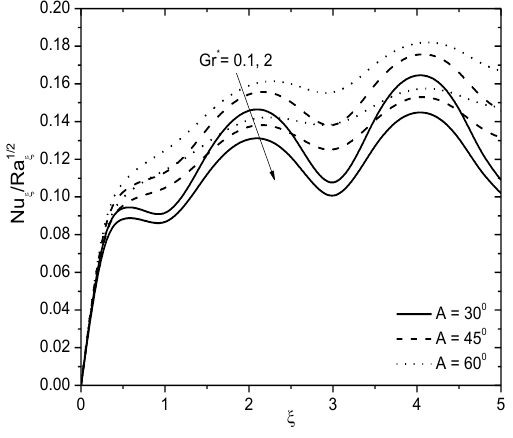
Figure 11. Effects of Gr * and A on local nanoparticle Sherwood number